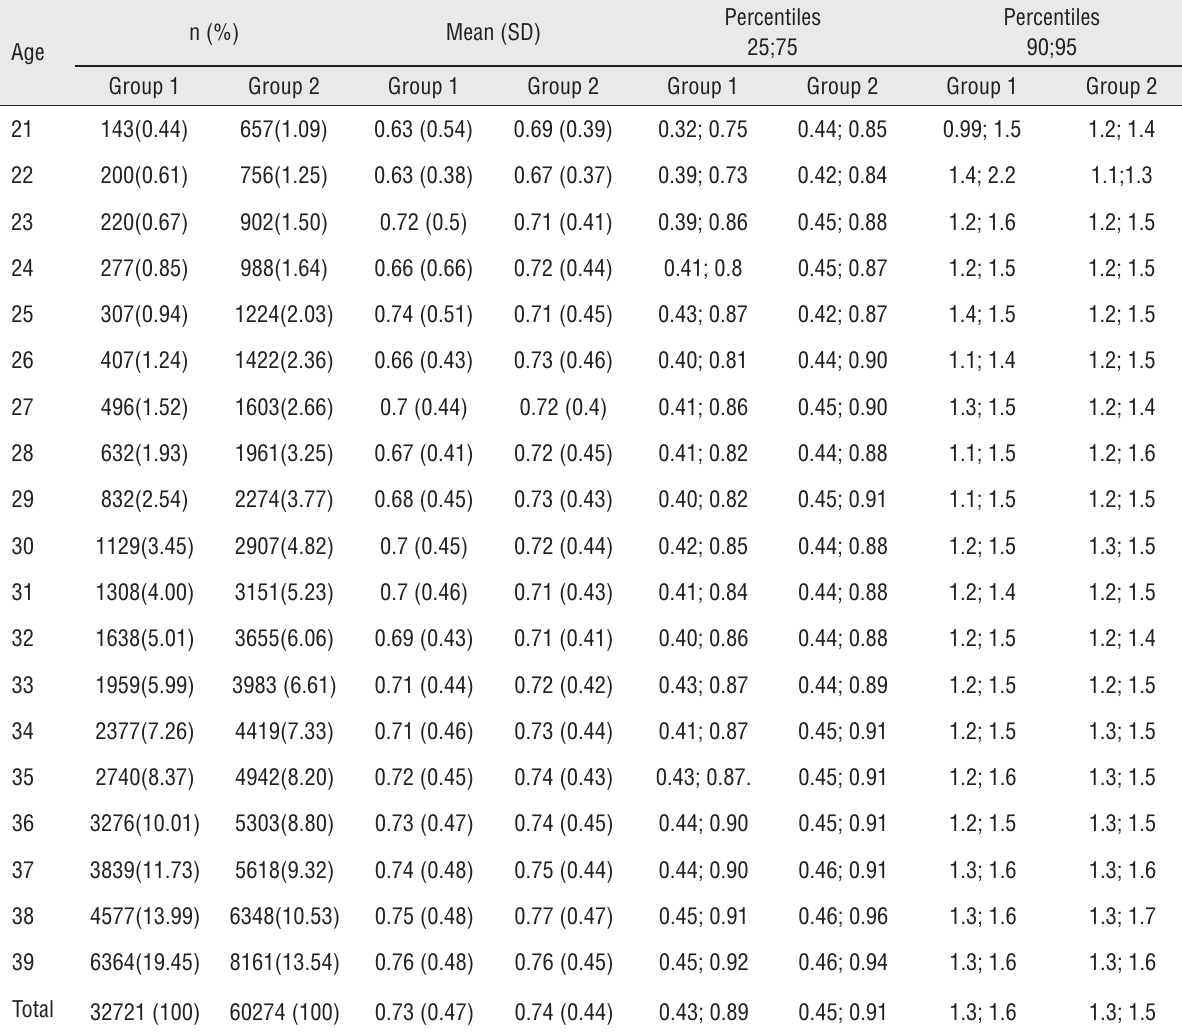
Table 3 - Descriptive analysis of Groups 1 and